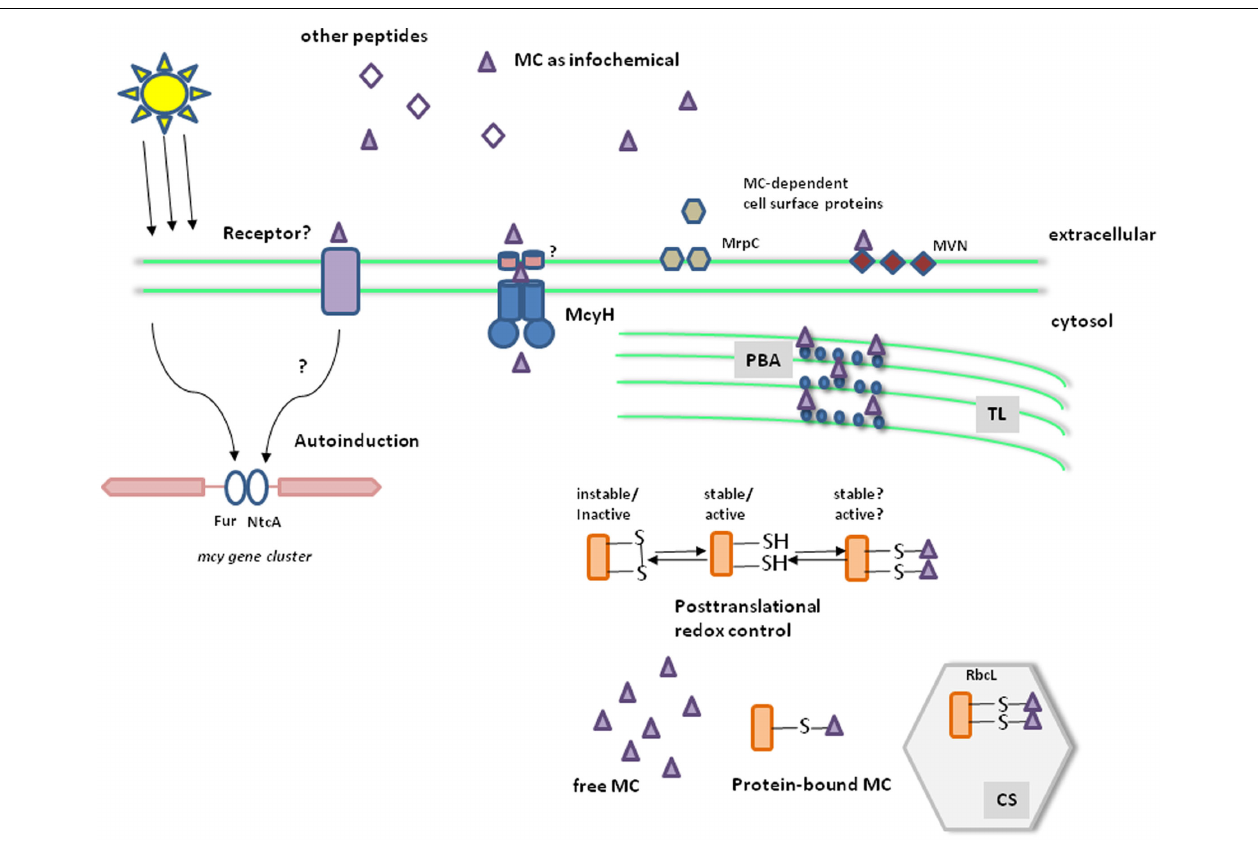
proteins such as the lectin MVN and the glycoprotein MrpC.The microcystin receptor is still unknown (middle). Inside cells, microcystin is partly bound to proteins. Binding partners include proteins of the phycobilisomes (PBA) and the large subunit of Rubisco (RbcL).The covalent binding to cysteines is preferentially formed under highlight and oxidative stress conditions. Microcystin can thus interfere with the known redox control of proteins and affect their stability and/or activity (right).TL, thylakoids; CS,